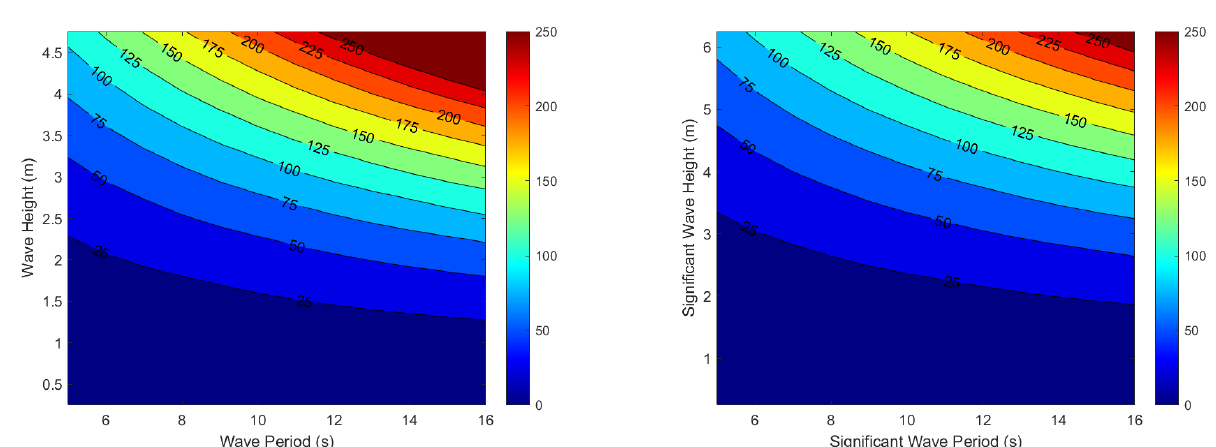
Fig. 6: Available wave power per unit span at different sea states. Left, regular wave conditions. Right, irregular wave conditions. Units are kW per meter of wave